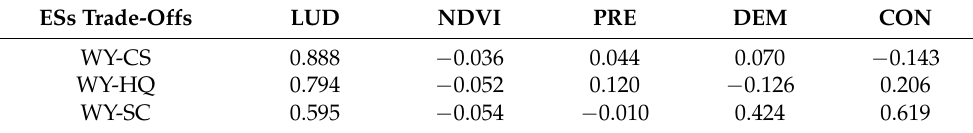
Figure 5. GWR coefficients between ES trade-offs and their influencing factors. Abbreviations: CS: carbon storage; WY: water yield; SC: soil conservation; HQ: habitat quality; LUD: dynamic degree of comprehensive land use change; NDVI: Normalized Difference Vegetation Index; PRE: precipitation; DEM: elevation; CON: percentage of construction land. Table 6. Mean statistics of GWR coefficients between ES trade-offs and influencing